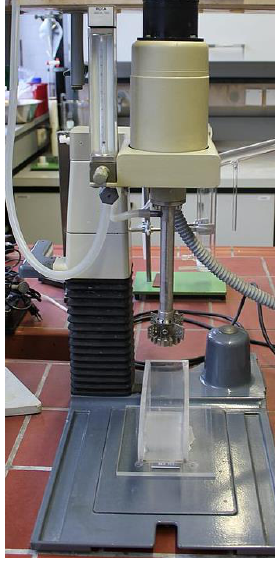
Figure 1. IFAD-construction Denver-type flotation machine.